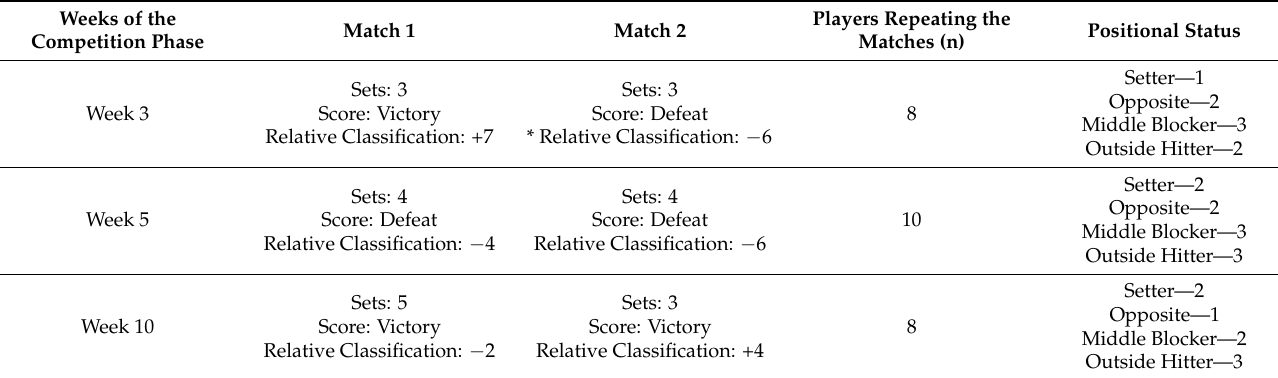
Table 1. Characteristics of the congested week schedules and classification at the